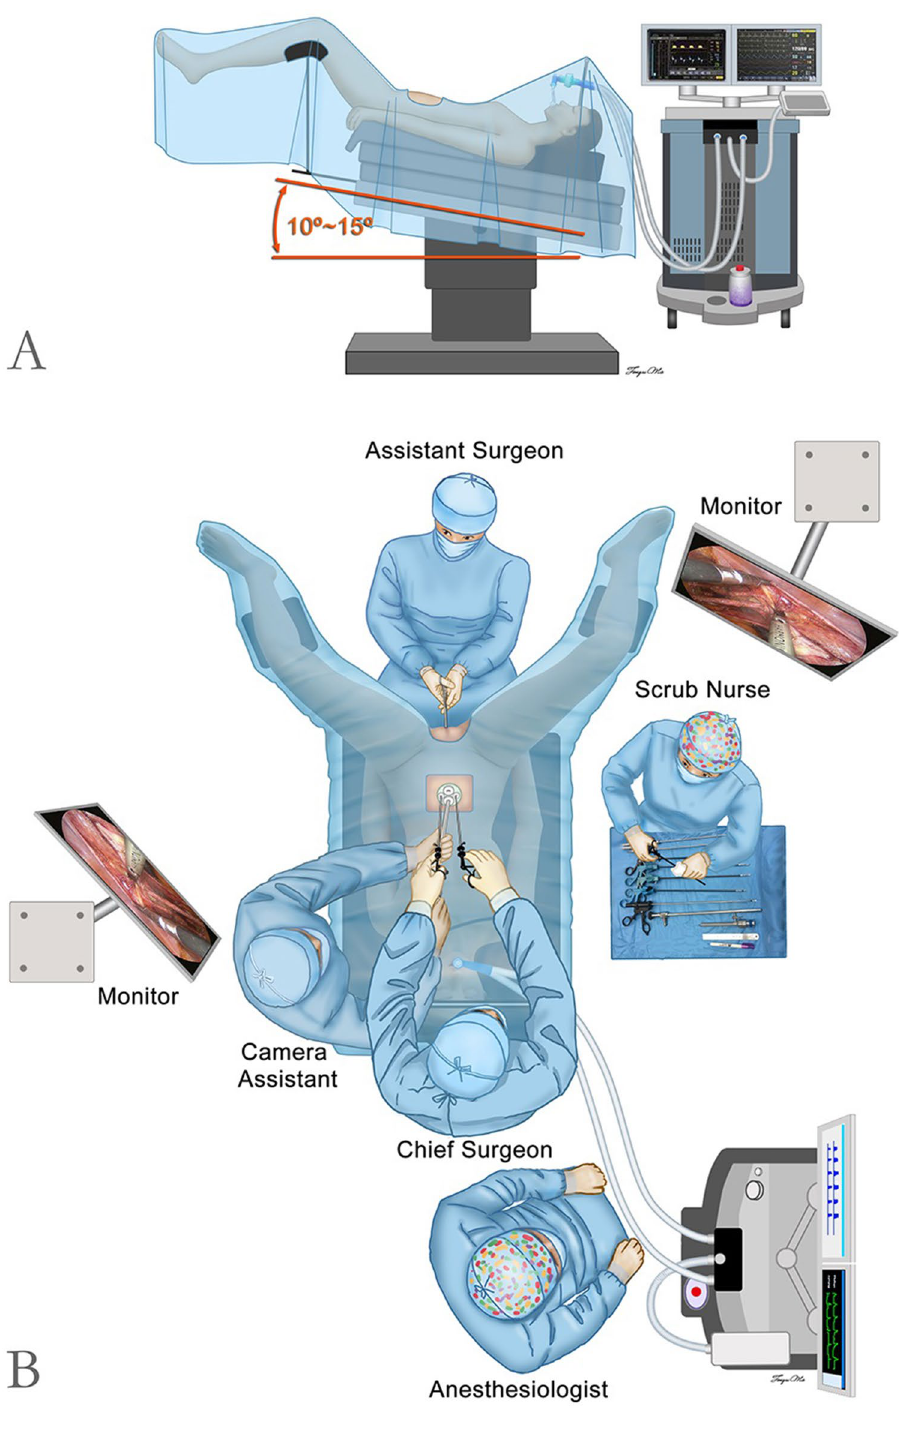
Figure 2. Surgical positioning and operating room setup for laparoendoscopic single-site radical hysterectomy(LESS-RH). ( A ) Surgical positioning and ( B ) operating room